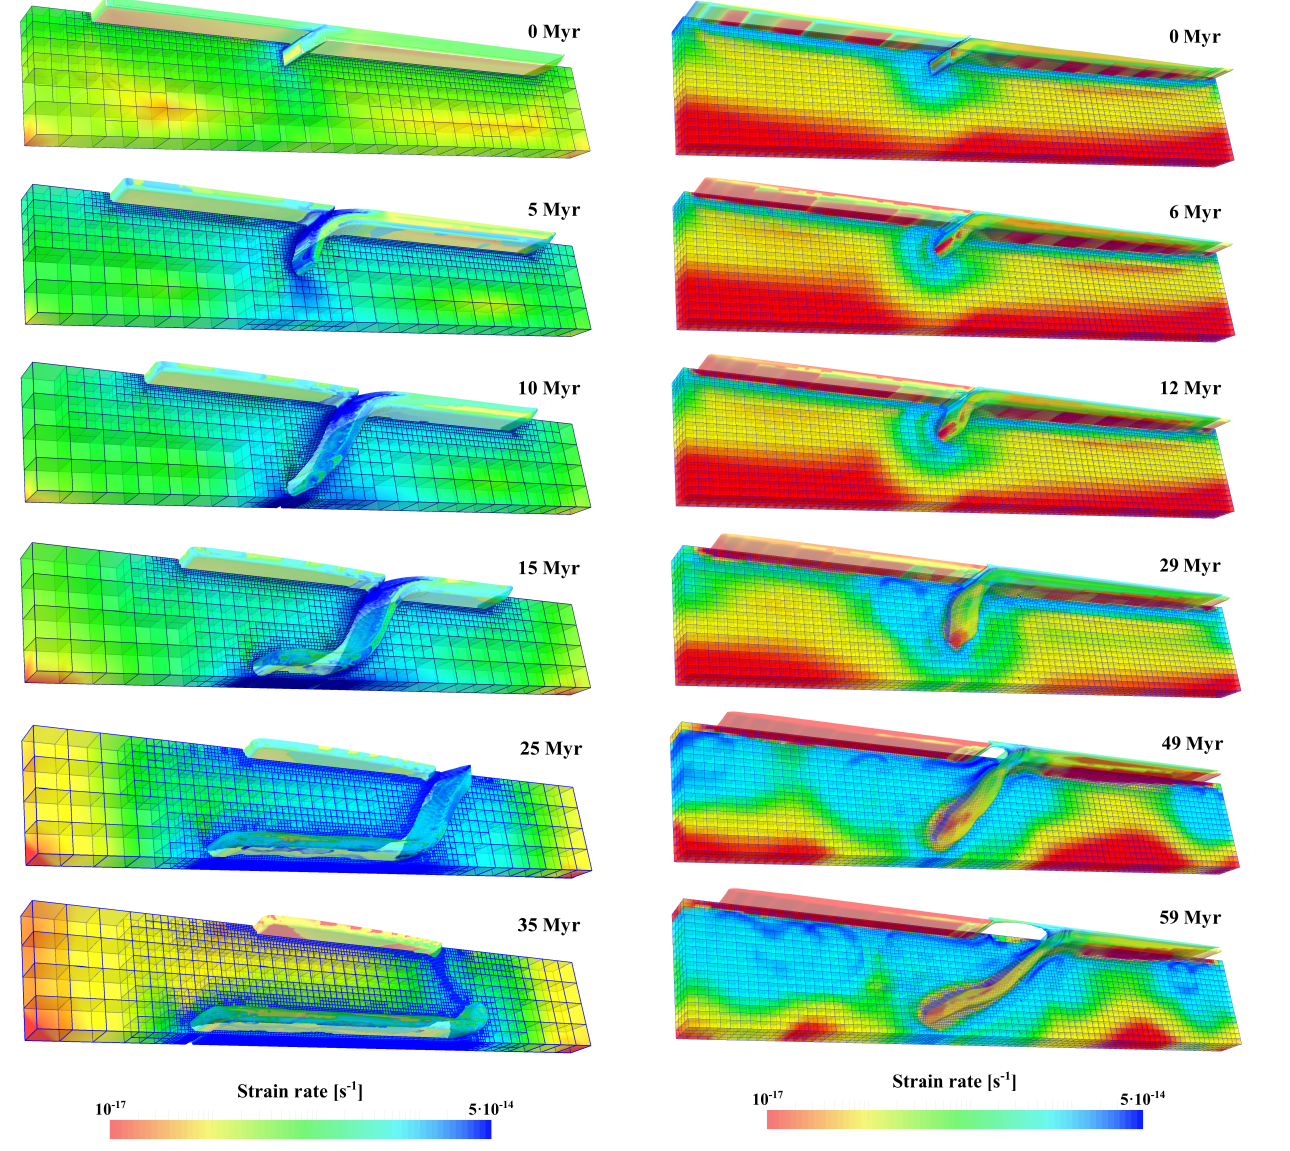
Figure 17. Model 1 – strain rate Frobenius norm together with SP and OP isocontours. Also shown is the adaptive mesh following the SP into the mantle.